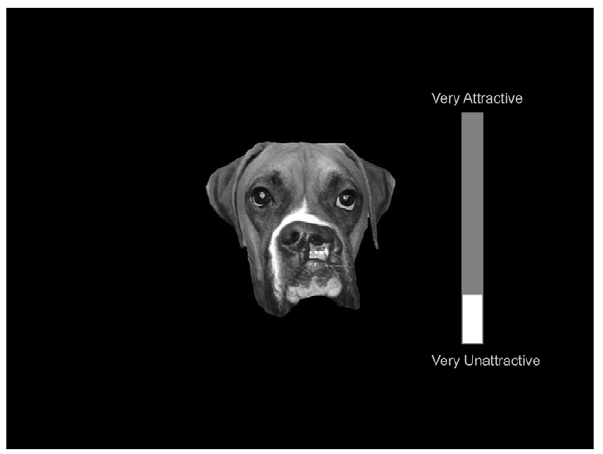
Figure 4. Example of an animal face with cleft lip, post-rating on the ‘liking’ task.